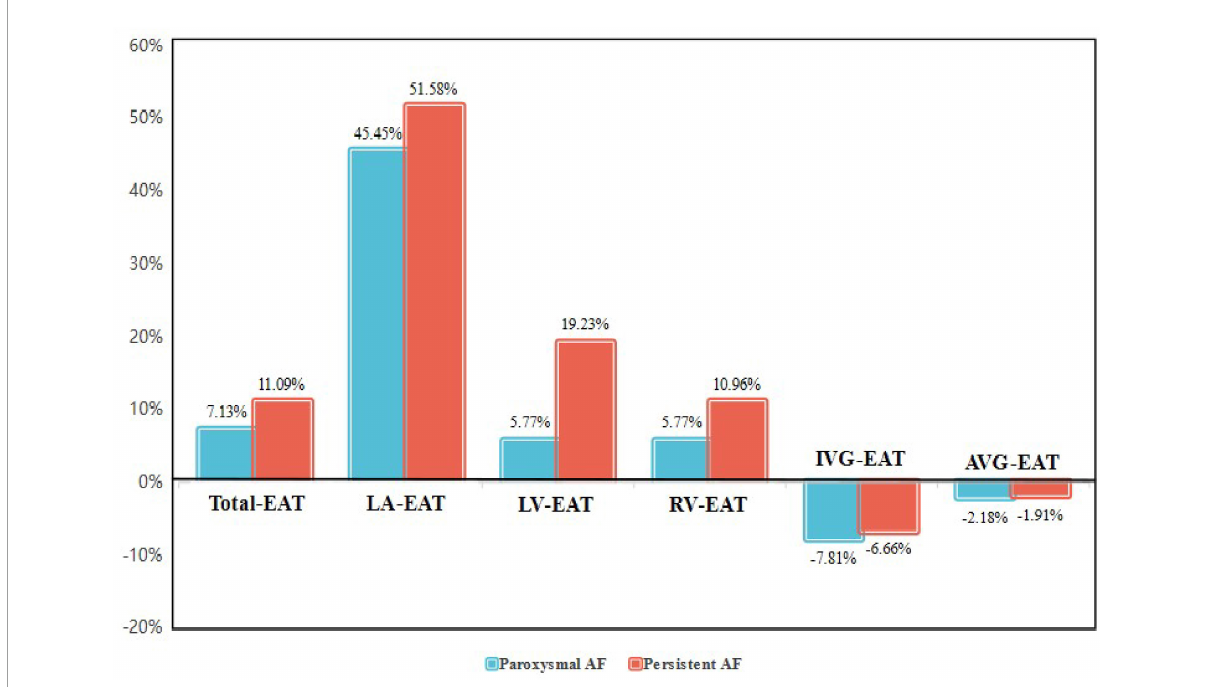
FIGURE3 The ratio of change in EAT relative to the control group in different regions of the heart in paroxysmal and persistent AF patients. AF, atrial fibrillation; EAT, epicardial adipose tissue; Total-EAT, mean EAT thickness surrounding the whole heart; LA-EAT, mean EAT thickness surrounding